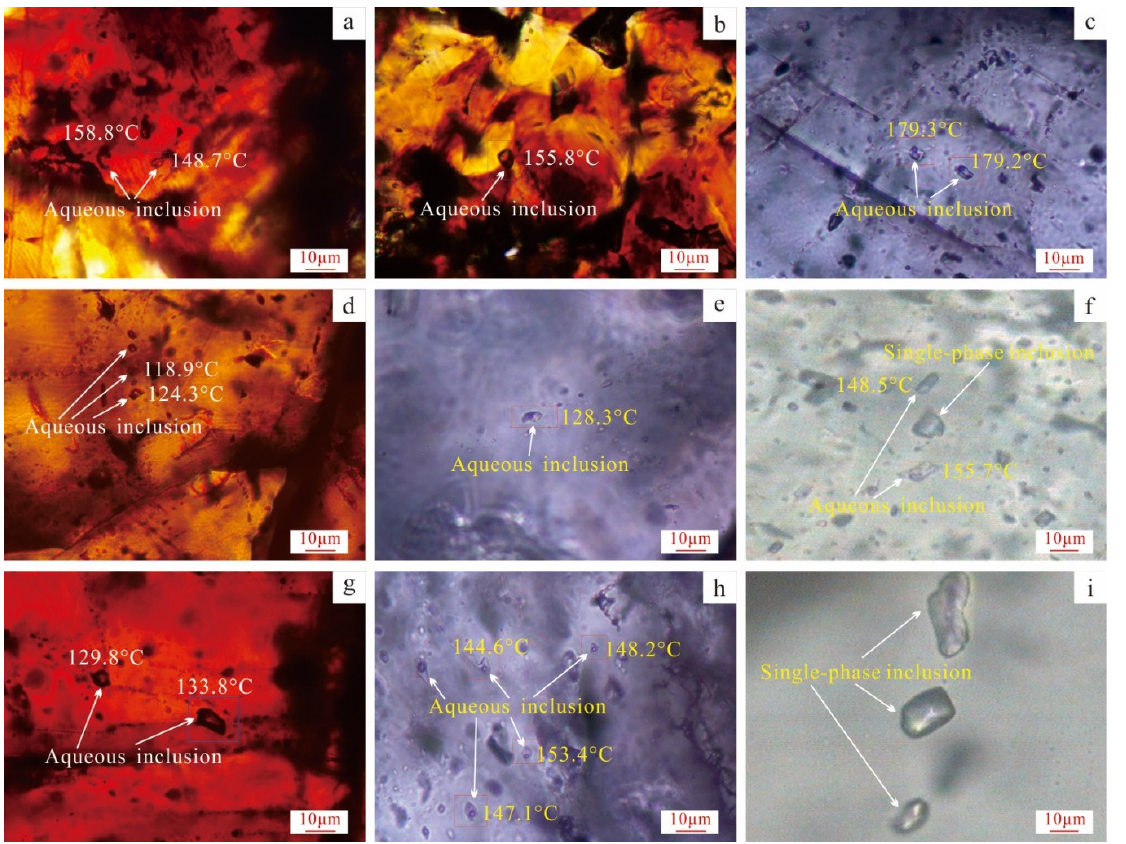
Figure 4. Photomicrographs under transmitted light of representative fluid inclusion types in sphal- erites and associated calcites and fluorites from Liuhuangdong orebody, Laoxi orebody, and Wujiahe orebody. ( a , b ) representative two-phase vapour–liquid aqueous inclusions in sphalerites from Li- uhuangdong orebody; ( c ) representative two-phase vapour–liquid aqueous inclusions in calcite from Liuhuangdong orebody; ( d ) representative two-phase vapour–liquid aqueous inclusions in sphalerite from Laoxi orebody; ( e , f ) representative two-phase vapour–liquid aqueous inclusions and single-phase inclusions in calcites from Laoxi orebody; ( g ) representative two-phase vapour–liquid aqueous inclusions in sphalerite from Wujiahe orebody; ( h , i ) representative two-phase vapour–liquid aqueous inclusions and single-phase inclusions in calcites from the Wujiahe